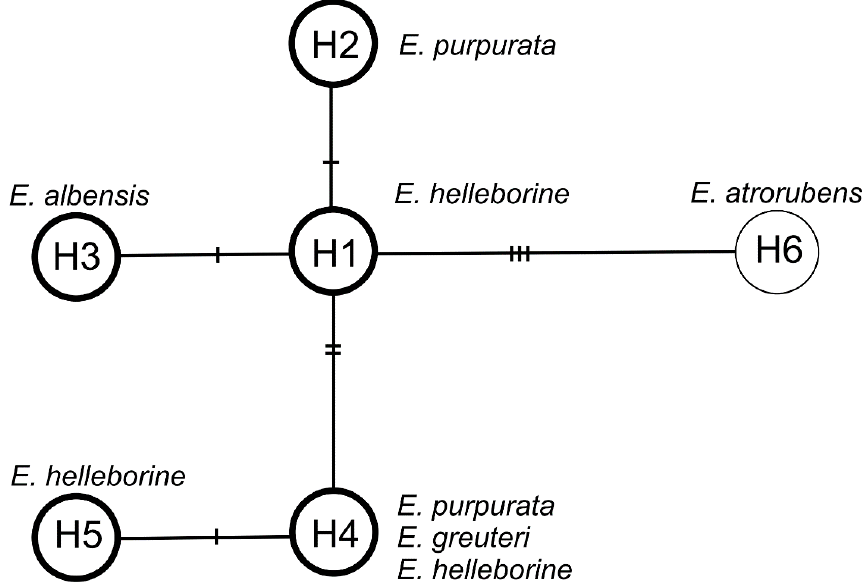
Figure 8. Median-joining network for plastid DNA haplotypes in Epipactis . The haplotypes are indicated by circles. The number of mutations required to explain transitions among haplotypes is indicated along the lines connecting the haplotypes by cross hatches. The haplotypes that have identical ITS (internal transcribed spacer) are bold in the circle.